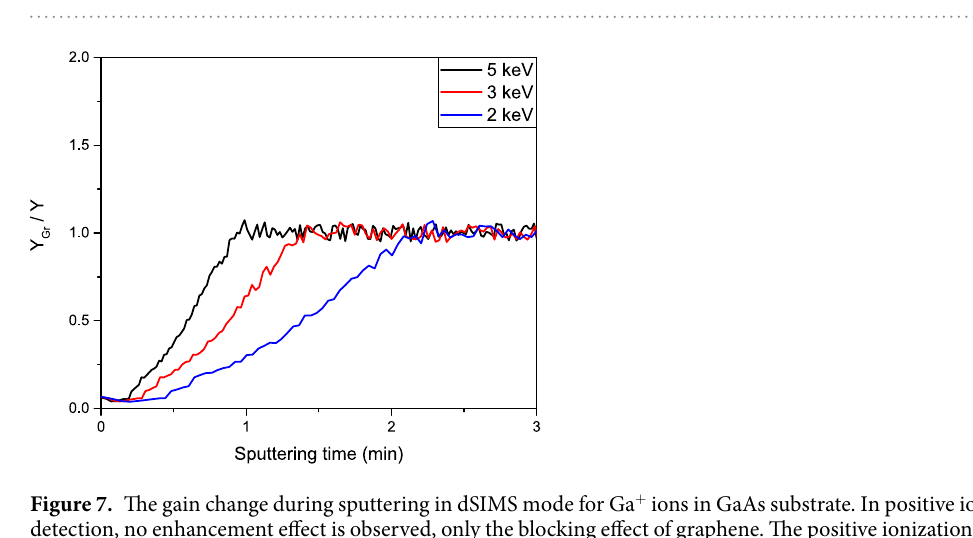
Figure 6. Static SIMS mode measurement for Sb dopant in Si substrate for samples with various dopant concentration: 1 * 10 18 and 1 * 10 16 atoms / cm 3 for Sample A and B, respectively. The presence of the graphene layer significantly increases the intensity of the SIMS signal, improving the detection limit. The GESIMS method allows the analysis of samples with low concentration, which is not possible using the standard measurement.